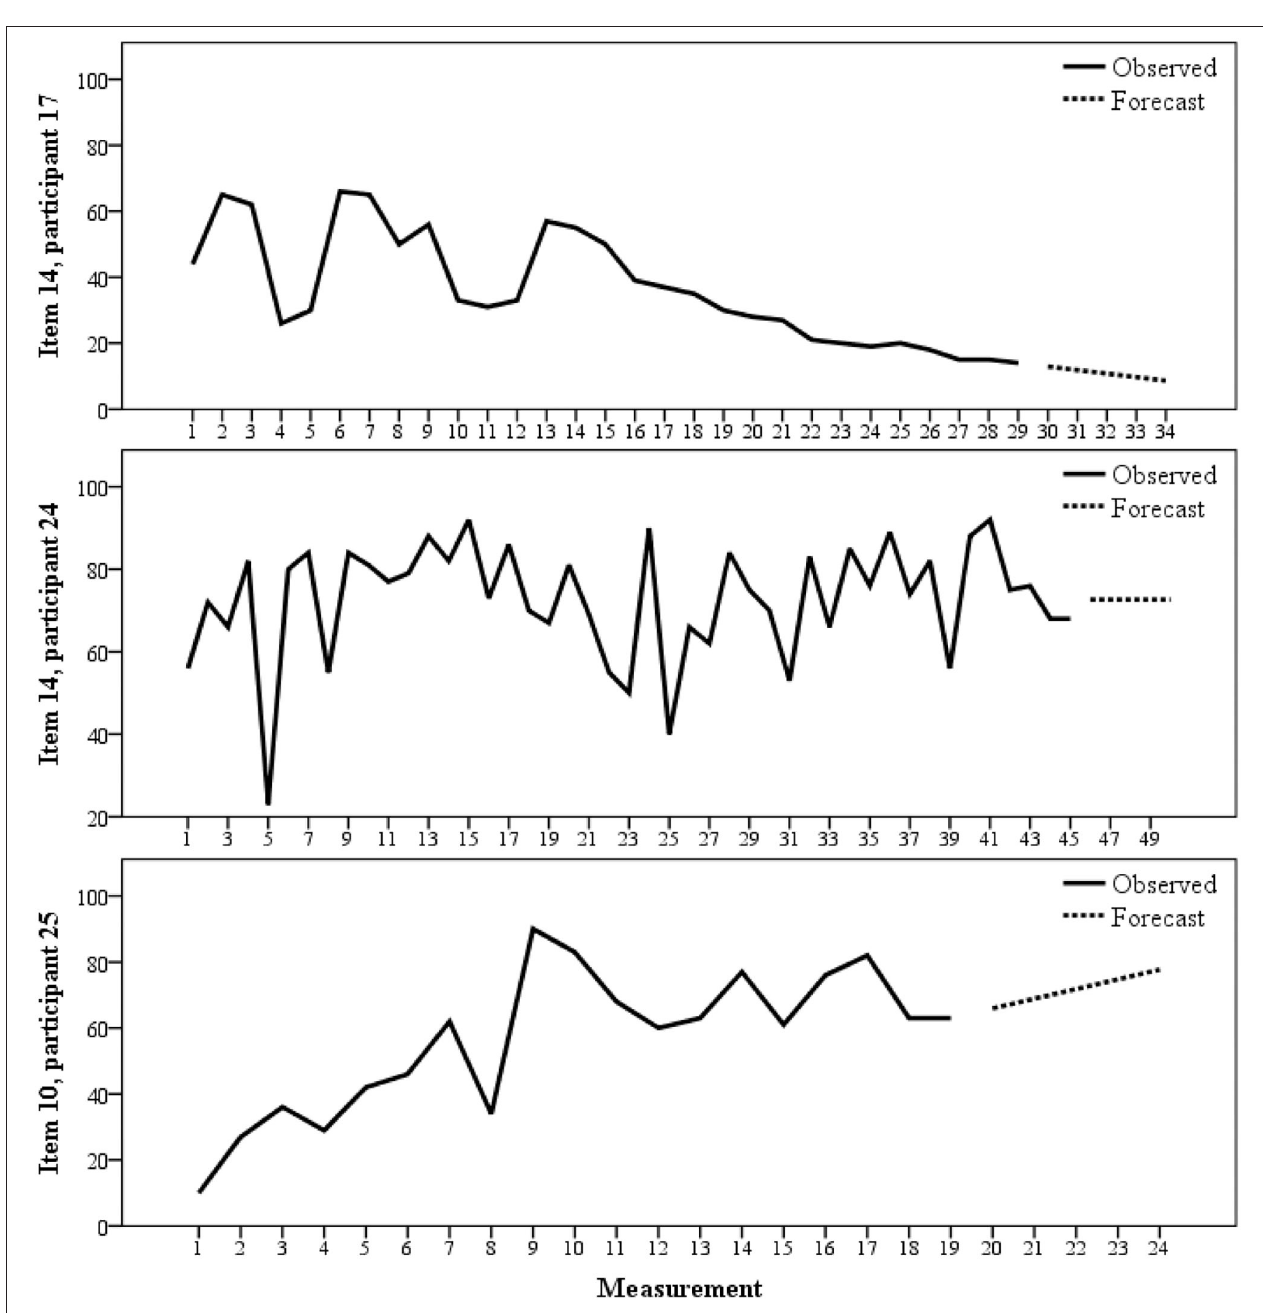
FIGURE 1 | PSIXPORT observed and predicted scores with ARIMA models in three participants.